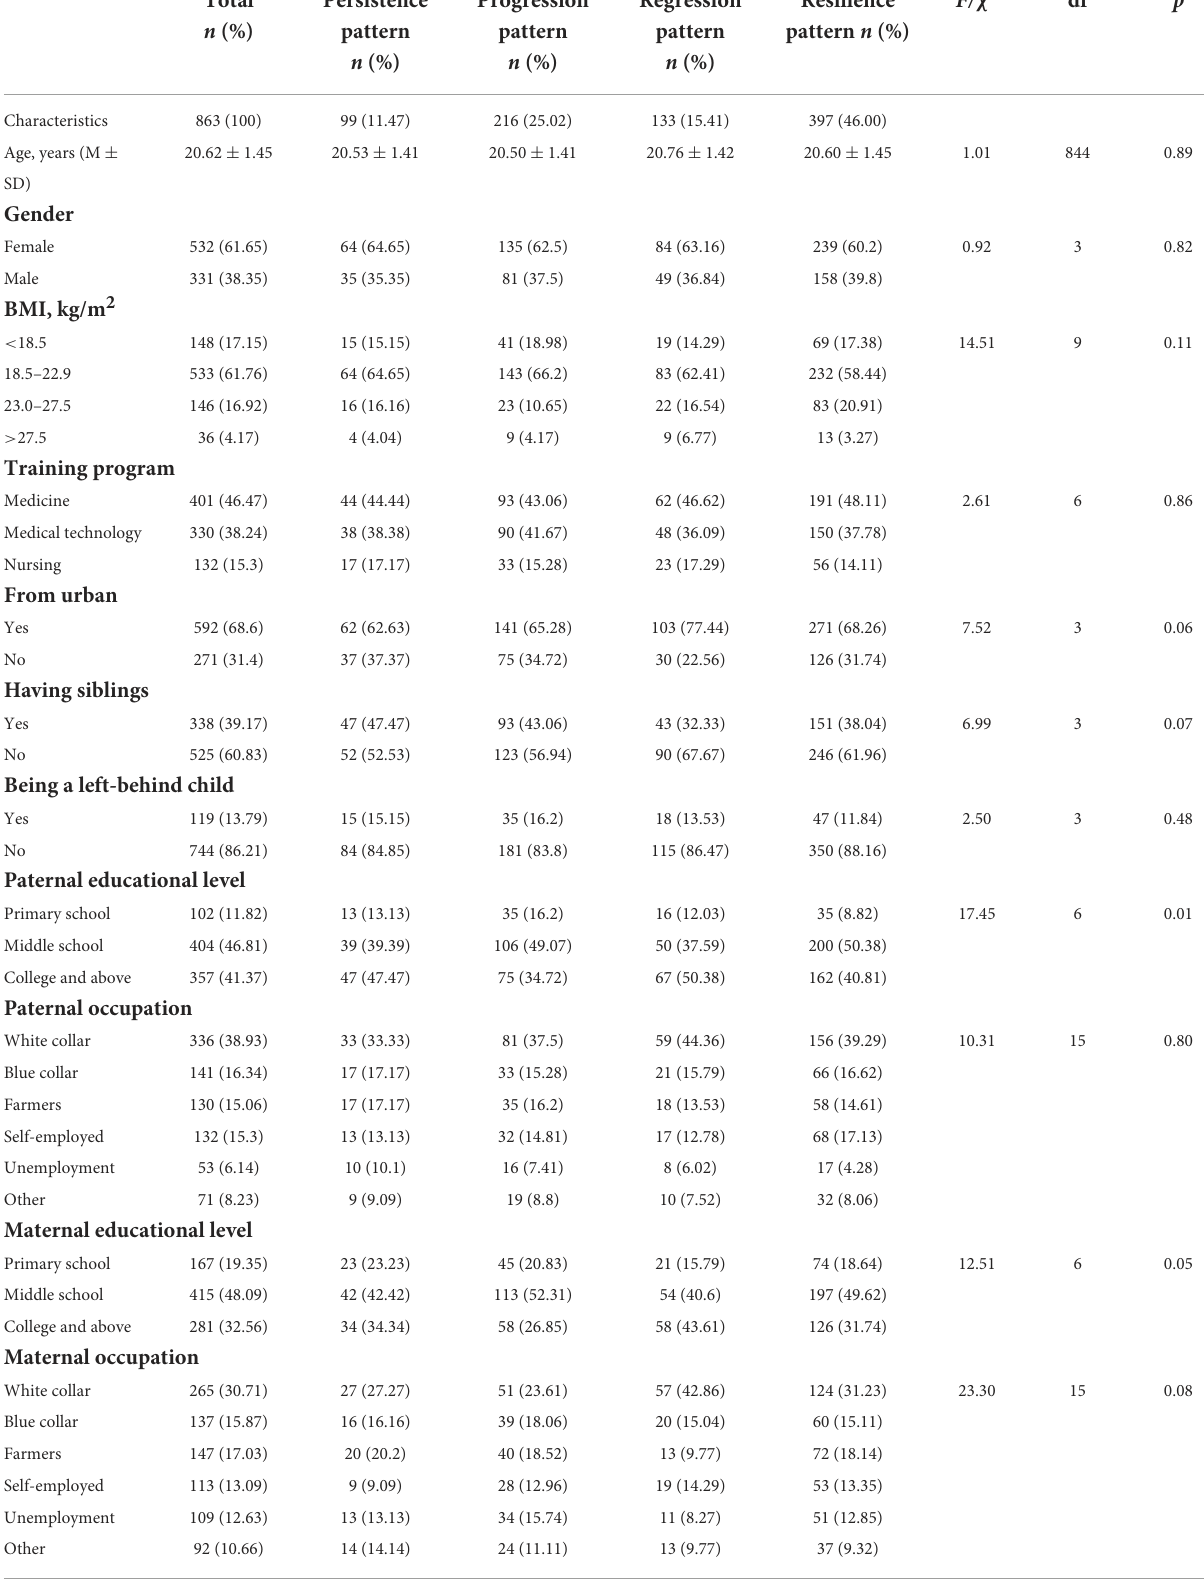
TABLE 1 Characteristics of the 863 undergraduate medical students a